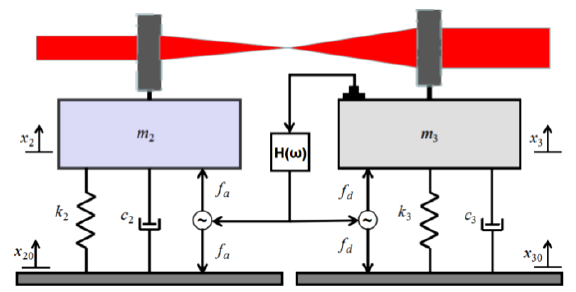
Figure 5. Optomechanical coupling active control system of the spatial filter.